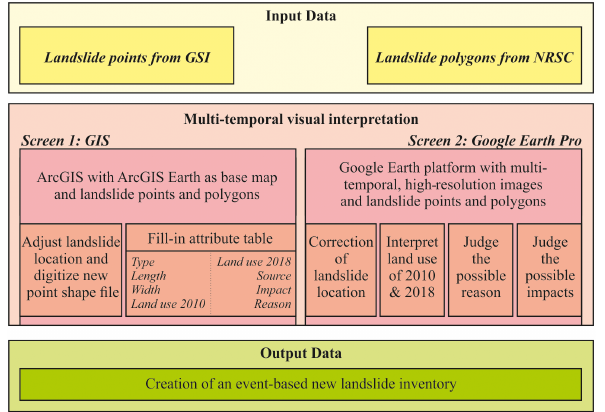
Figure 13. Overview of the methodology adopted for the creation of a new landslide inventory in this